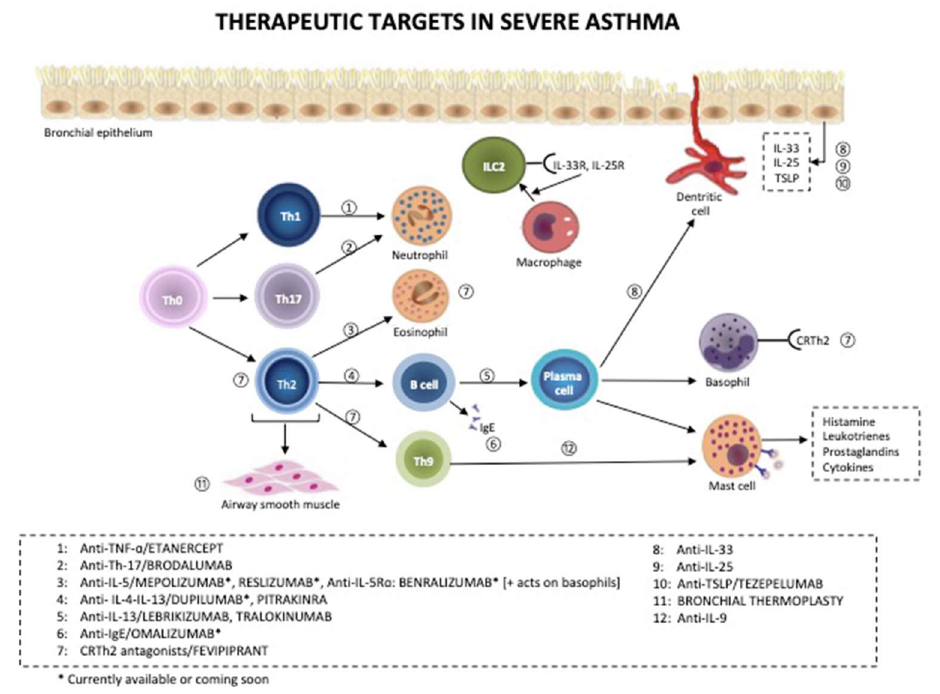
Figure 3. Inflammatory pathways of severe asthma and potential targets of biologic drugs.